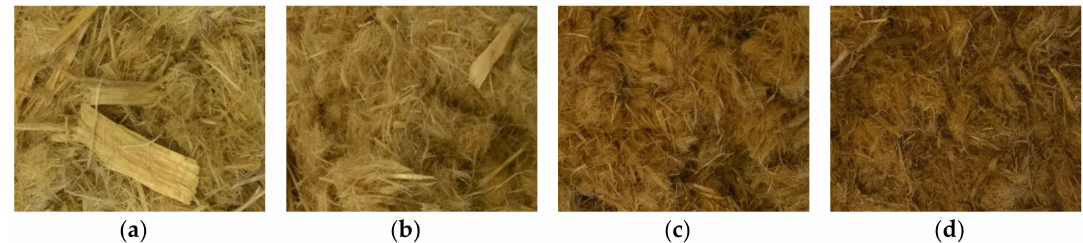
Figure 7. Morphology of spruce wood after steam refining using di ff erent treatment conditions [log R 0 ; ◦ C; min]: ( a ) 2.47; 150; 10, ( b ) 3.06; 160; 20, ( c ) 3.36; 180; 10, ( d ) 3.95; 190; 20.